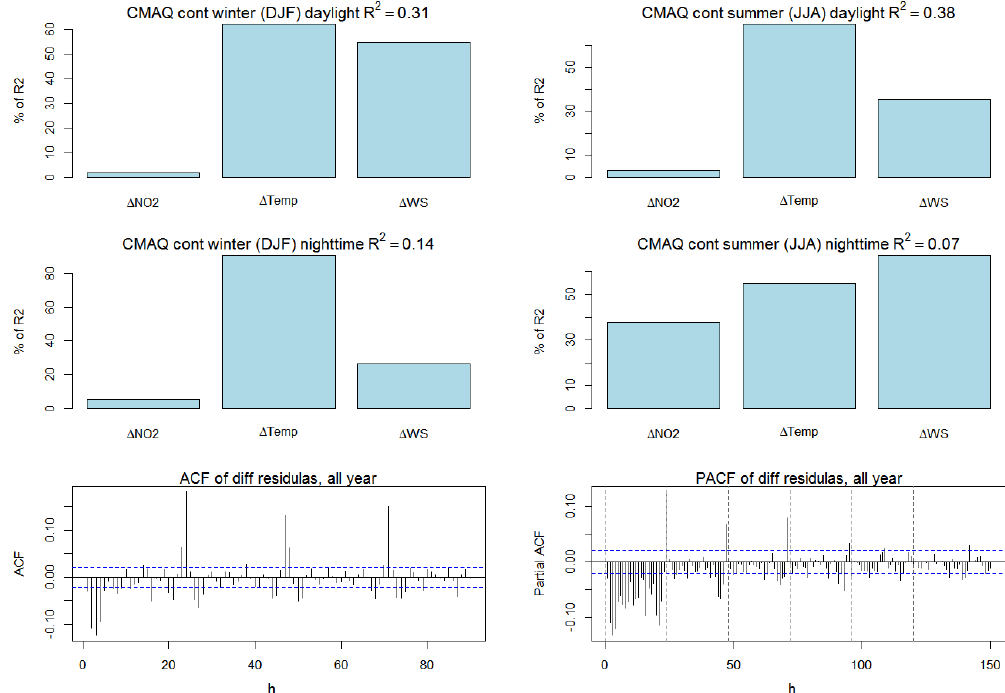
Figure 27. Percentage of variance explained by the regressors (the total R 2 for the regression is reported in the title of each panel). The relative importance of each variable is assessed by using a bootstrap resampling. The plots at the bottom show the ACF and PACF of the yearly time series of residual of the fit, i.e. the portion of the ozone time series that was not captured by the linear regressions on the available variables. The analysis encompasses 47 co-located stations (the NA stations for ozone, NO 2 , WS, and Temp that fall in a radius of 1000m and vertical displacement less than